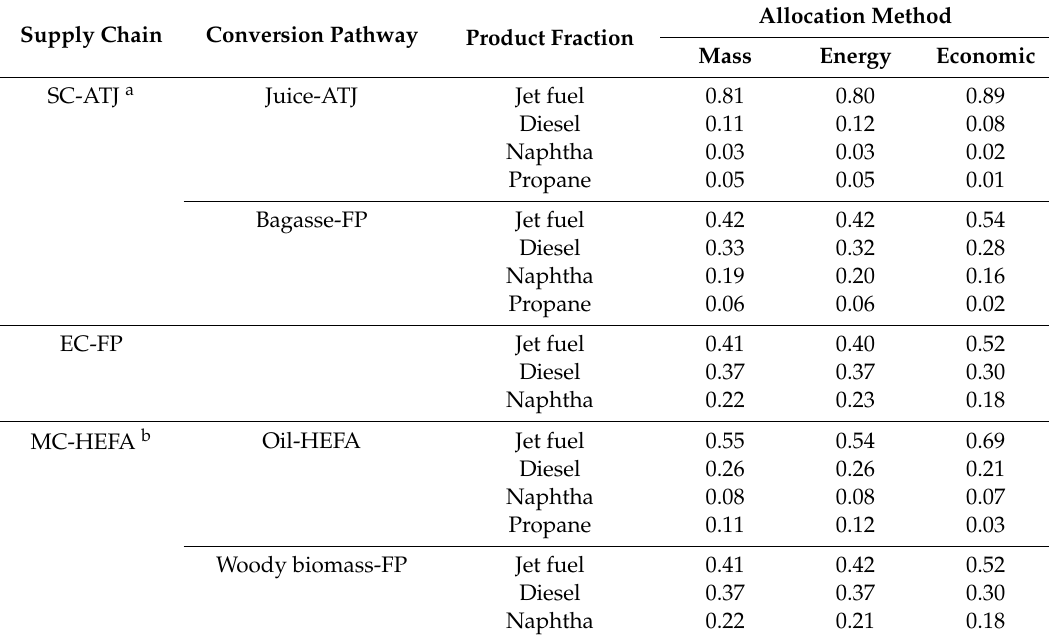
Table 2. Allocation factors used for aviation biofuel and co-products (SC: sugarcane, EC: eucalyptus, and MC: